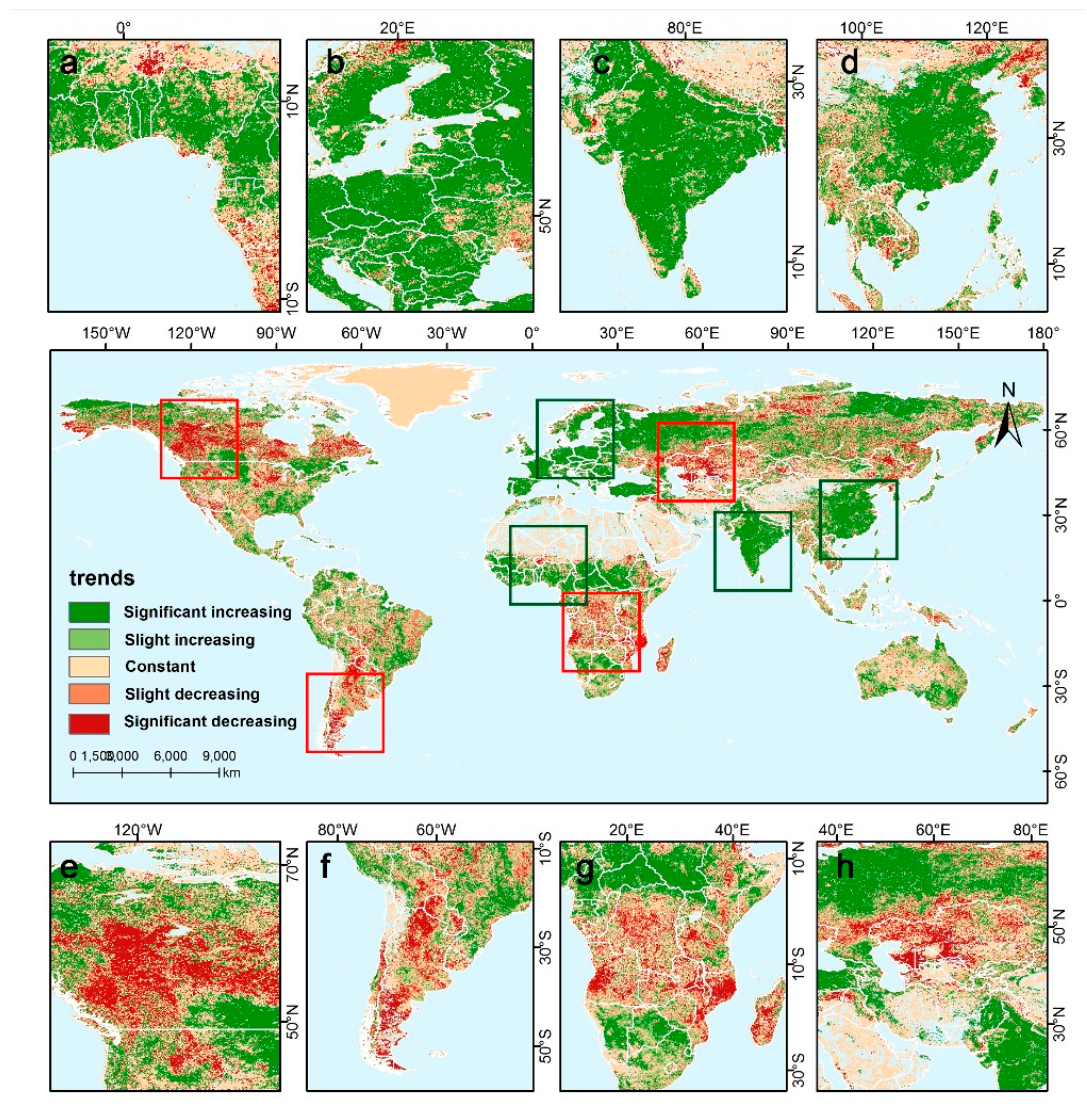
Figure 4. Spatial distribution of the temporal trends in NDVI from 1982 to 2015. (( a–d ) is the major greening area in the world; ( e – h ) is the major browning area in the world)